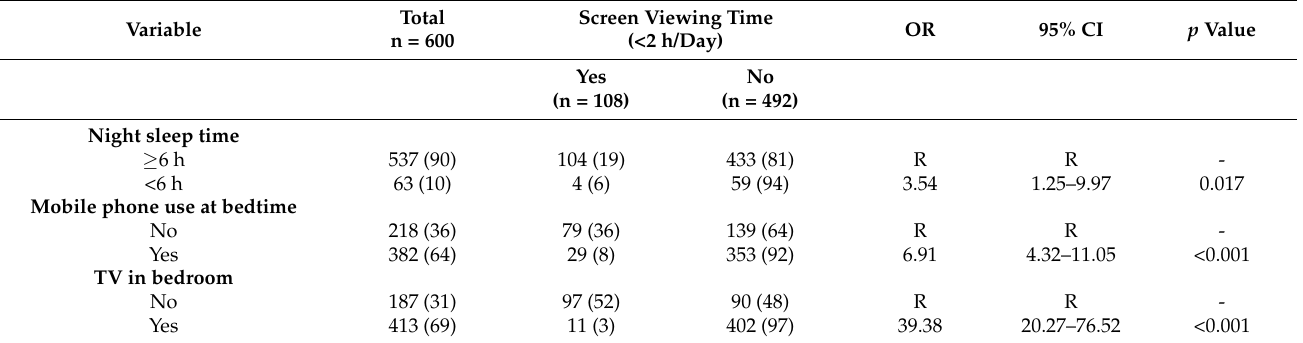
Table 2. Bivariate analysis of association of type of screen time, its duration, and child-related health factors with the outcome of <2 h/day of screen viewing in the 600 children included in the